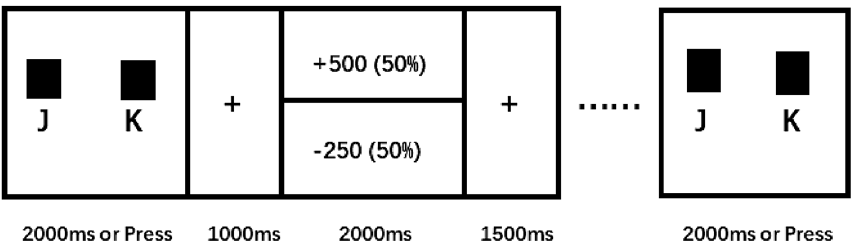
Figure 1. Diagram outlining the experimental design (arrows were displayed in the actual experiment feedback instead of